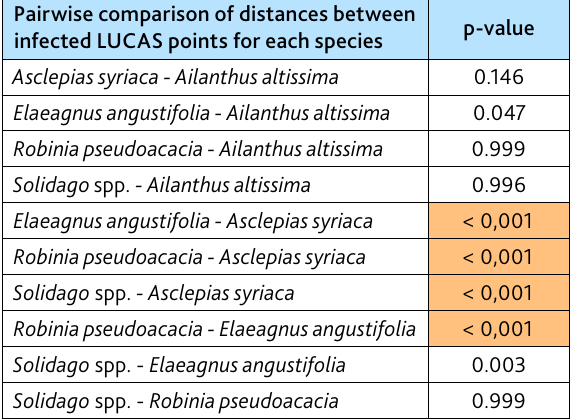
Table 2. Statistical analysis of the distances between LUCAS points infected with each species Pairwise comparison of distances between infected LUCAS points for each species